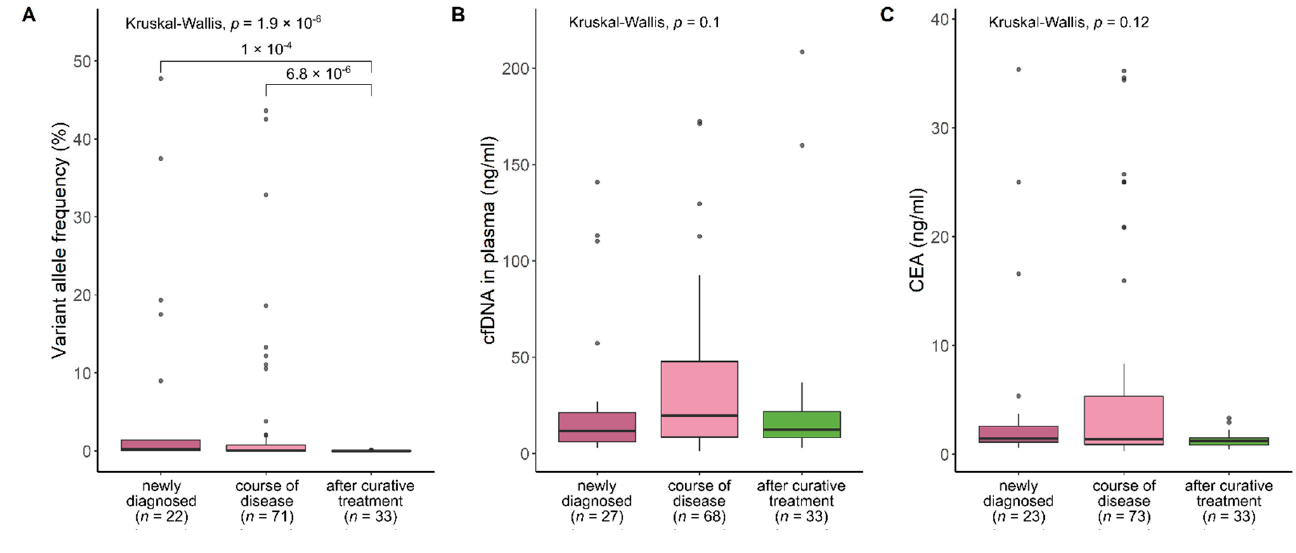
Figure 5. ctDNA VAFs, cfDNA concentration and CEA levels at different times in the course of the disease. ( A ) ctDNA quantification levels but not ( B ) cfDNA concentration and ( C ) CEA levels significantly differ at different times in the course of disease.